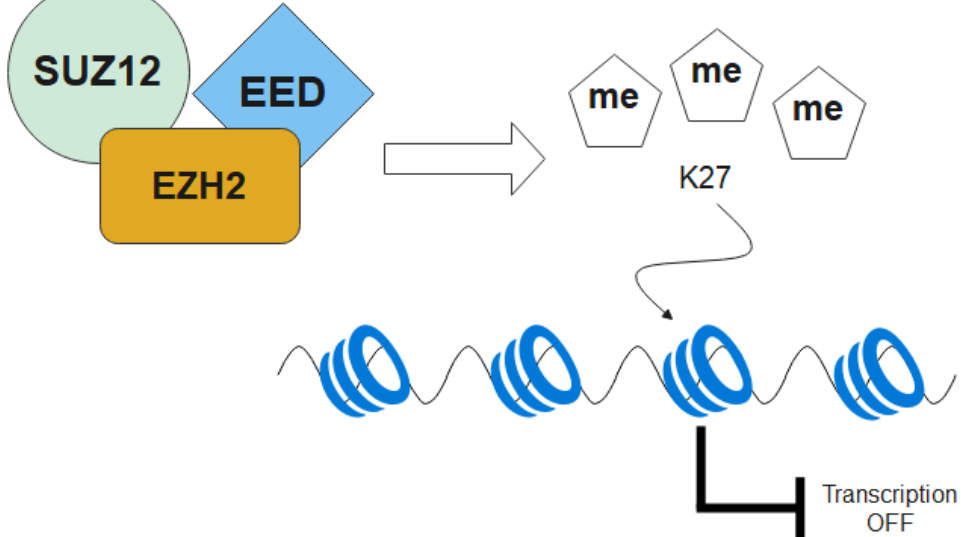
Figure 4. Mechanism of histone modification in MDS. Under normal circumstances, the PRC2 com- plex promotes methylation by regulating H3K27me resulting in transcriptional activation. However, loss-of-function mutation of EZH2 causes PCR2 to malfunction resulting in HSC disorders.